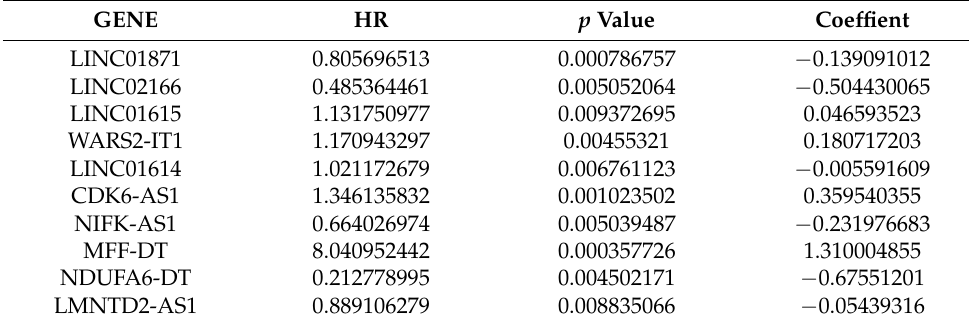
Table 3. Details of 10 AR-lncRNAs used to construct prognostic signatures.